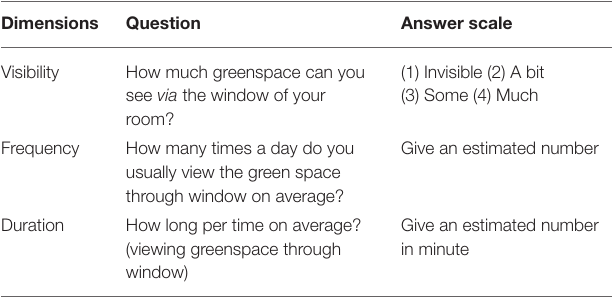
TABLE 1 | Questions for nature exposure through window.